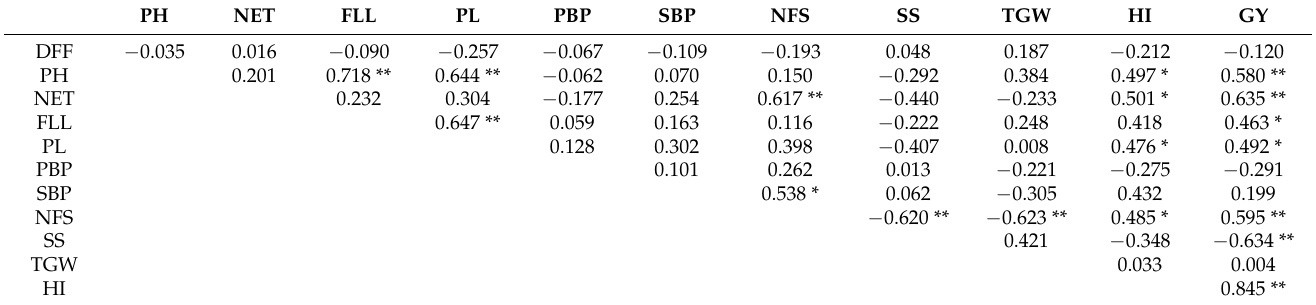
Table 4. The phenotypic correlation coefficient among 12 characters in 20 genotypes of T. Aman